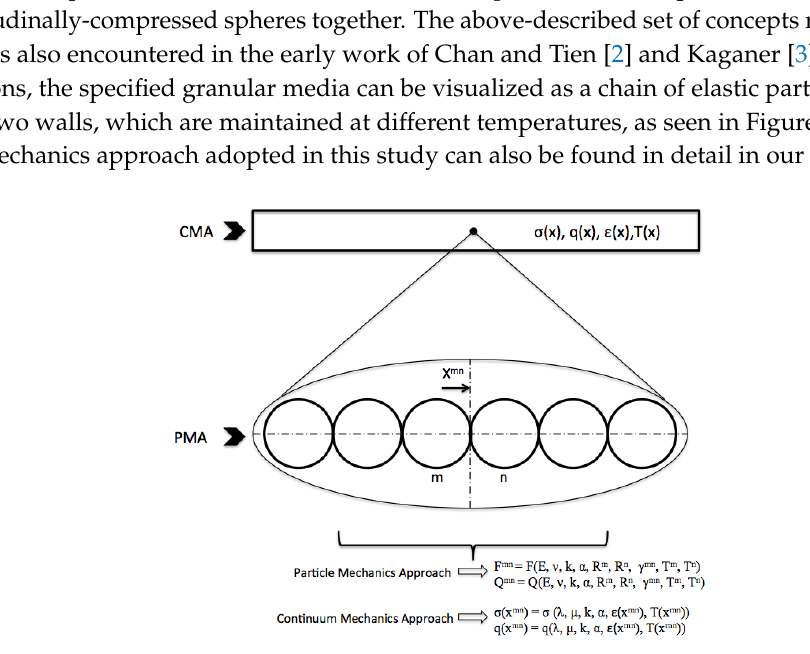
Figure 1. Particle and continuum mechanics